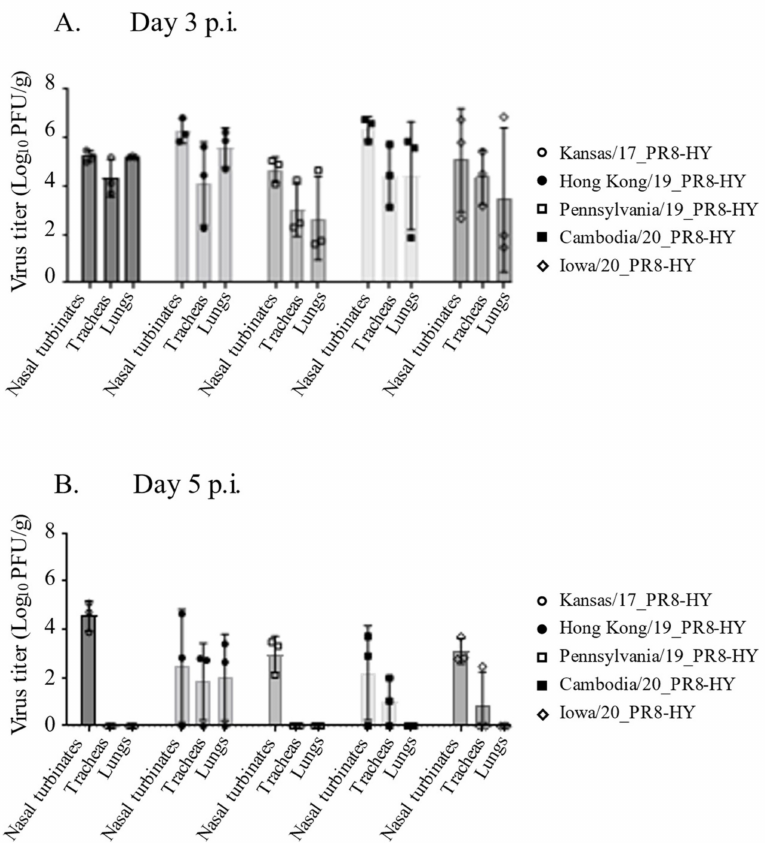
Figure 2. Replication of recombinant human H3N2 viruses in Syrian hamsters. Syrian hamsters (six per virus) were infected with 10 6 PFU of recombinant virus with the respective HA and NA genes on the PR8-HY backbone. On days 3 and 5 p.i., three animals from each group were euthanized and virus titers in the nasal turbinates, tracheas, and lungs were determined in hCK